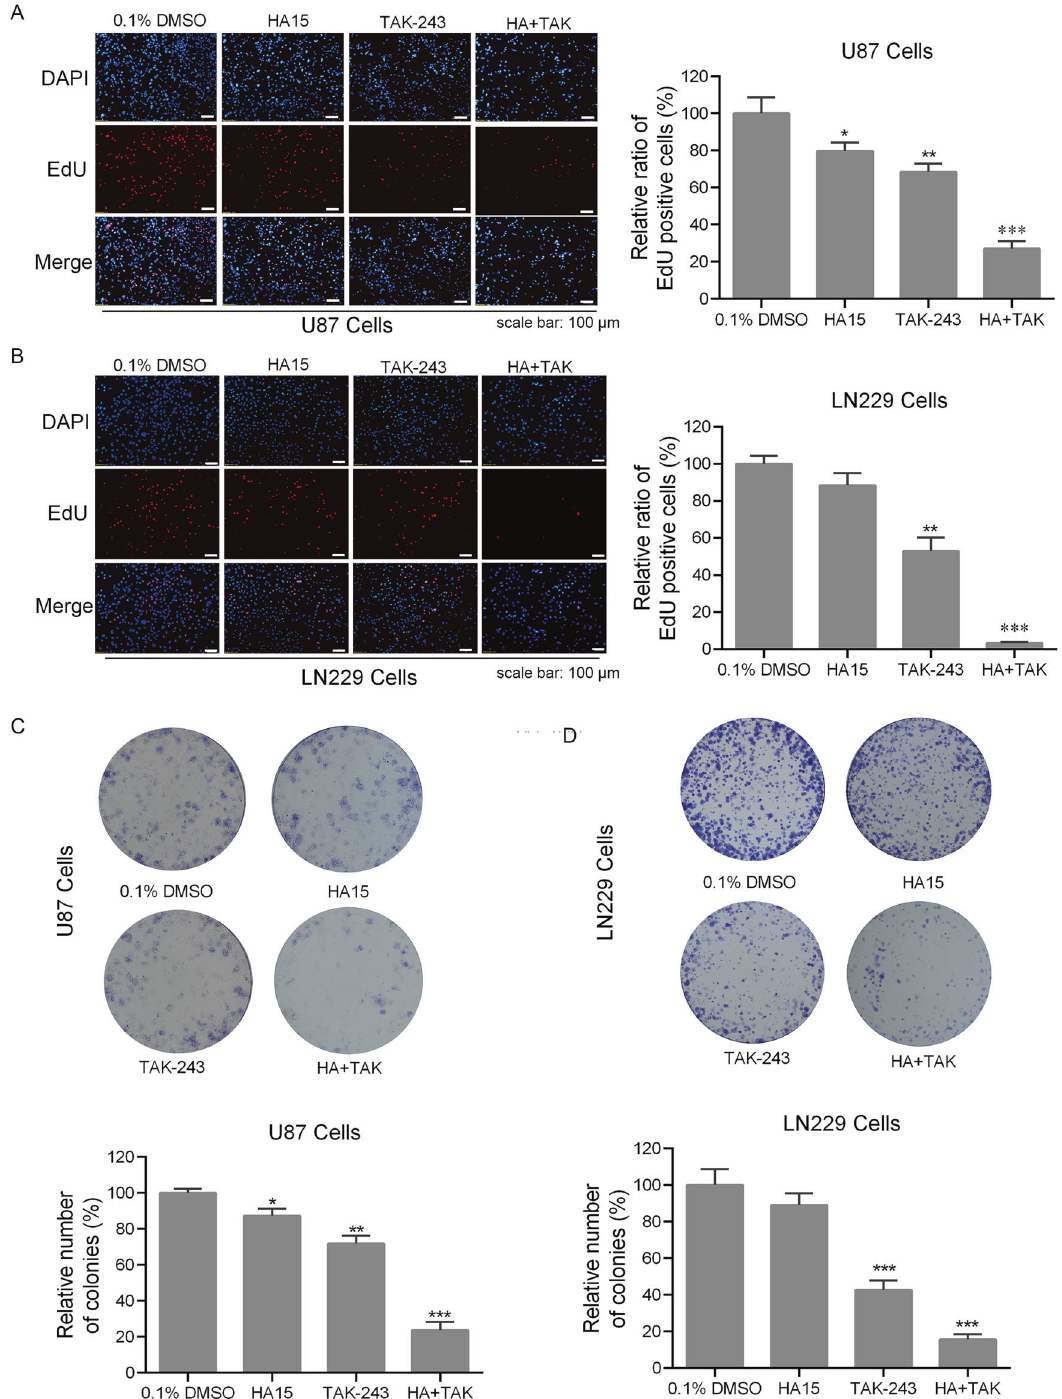
Fig. 2 HA15 enhanced the inhibitory effect of TAK-243 on proliferation and colony formation of GBM cells. A , B Measurement of antiproliferation effects of TAK-243 (100 nM) and/or HA15 (10 μΜ ) by EdU incorporation assays. Quantitative results of EdU incorporation assay were analyzed. The number of proliferative cells were normalized to that of the control group. Scale bar: 100 μ m. C , D U87 and LN229 cells were treated with different concentrations of TAK-243 (100 nM) and/or HA15 (10 μΜ ) for 24 h, and then changed with drug-free medium for another 12 days. The numbers of colony formation were counted. The numbers of colony formation were normalized to the control group. All the data were presented as means ± SD from three independent experiments (* P < 0.05, ** P < 0.01, *** P < 0.001). TAK-243-monotehrapy group, the apoptosis induced by TAK-243 TAK-243 combination therapy increased the proportion of GBM was signi fi cantly increased after the combined usage of HA15 in cells in G2/M phases. However, no signi fi cant differences in the treatment (Fig. 3C). The same effect was observed in LN229 cells proportion of cell cycle phase were found between the HA15- as well (Fig. 3D). These fi ndings indicated that HA15 + TAK-243 monotherapy and the vehicle groups (Fig. 3A, B). Compared with